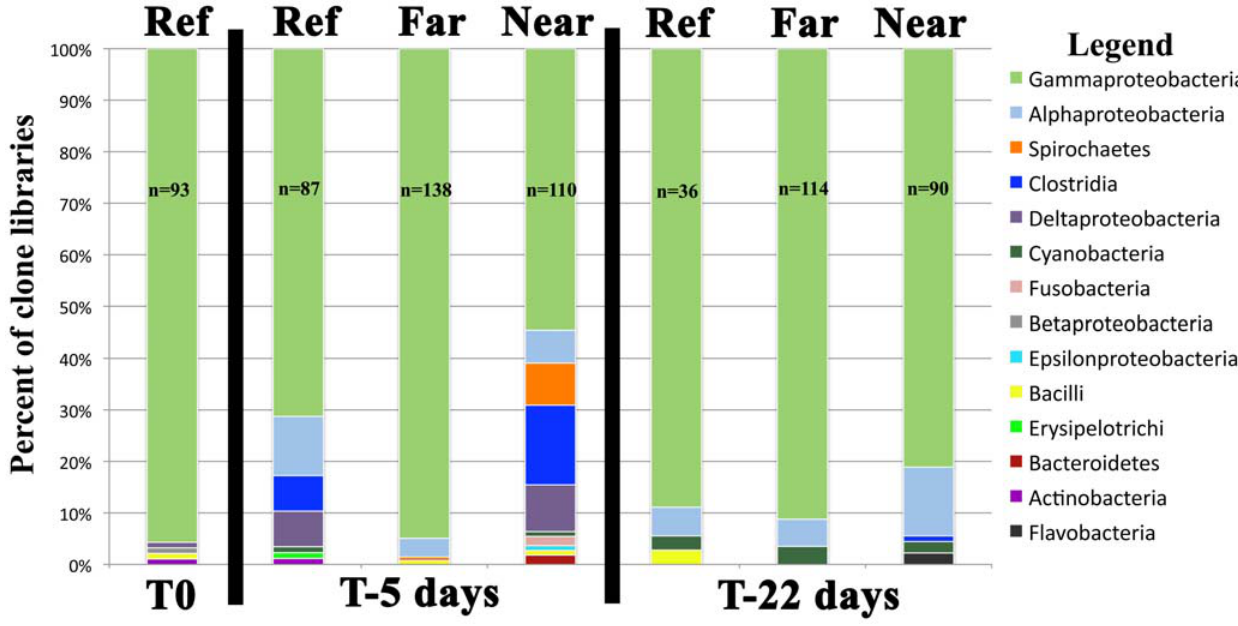
Figure 4. The distribution of phylotypes by class from 16S rRNA clone libraries. Libraries have been pooled by site (i.e. libraries from all fragments at a given time point from Far-1 and Far-2 are represented by ‘‘Far’’ and the same is true for ‘‘Near’’) and each individual time point (T0, T-5 days, T-22 days) is shown separately. The number of sequences represented is denoted as ‘‘n=’’. Spirochaetes, previously seen only in corals infected with diseases, and Clostridia are both present even though fragments showed no visible signs of disease. Spirochaetes sequences are only present at T-5 days and predominantly at high effluent sites.